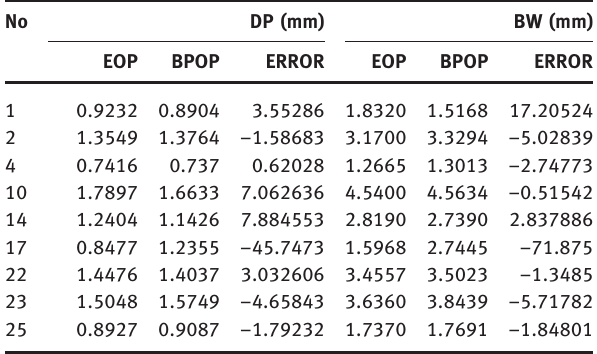
Table 8: First bead on plate welding conditions employed for process parameter.